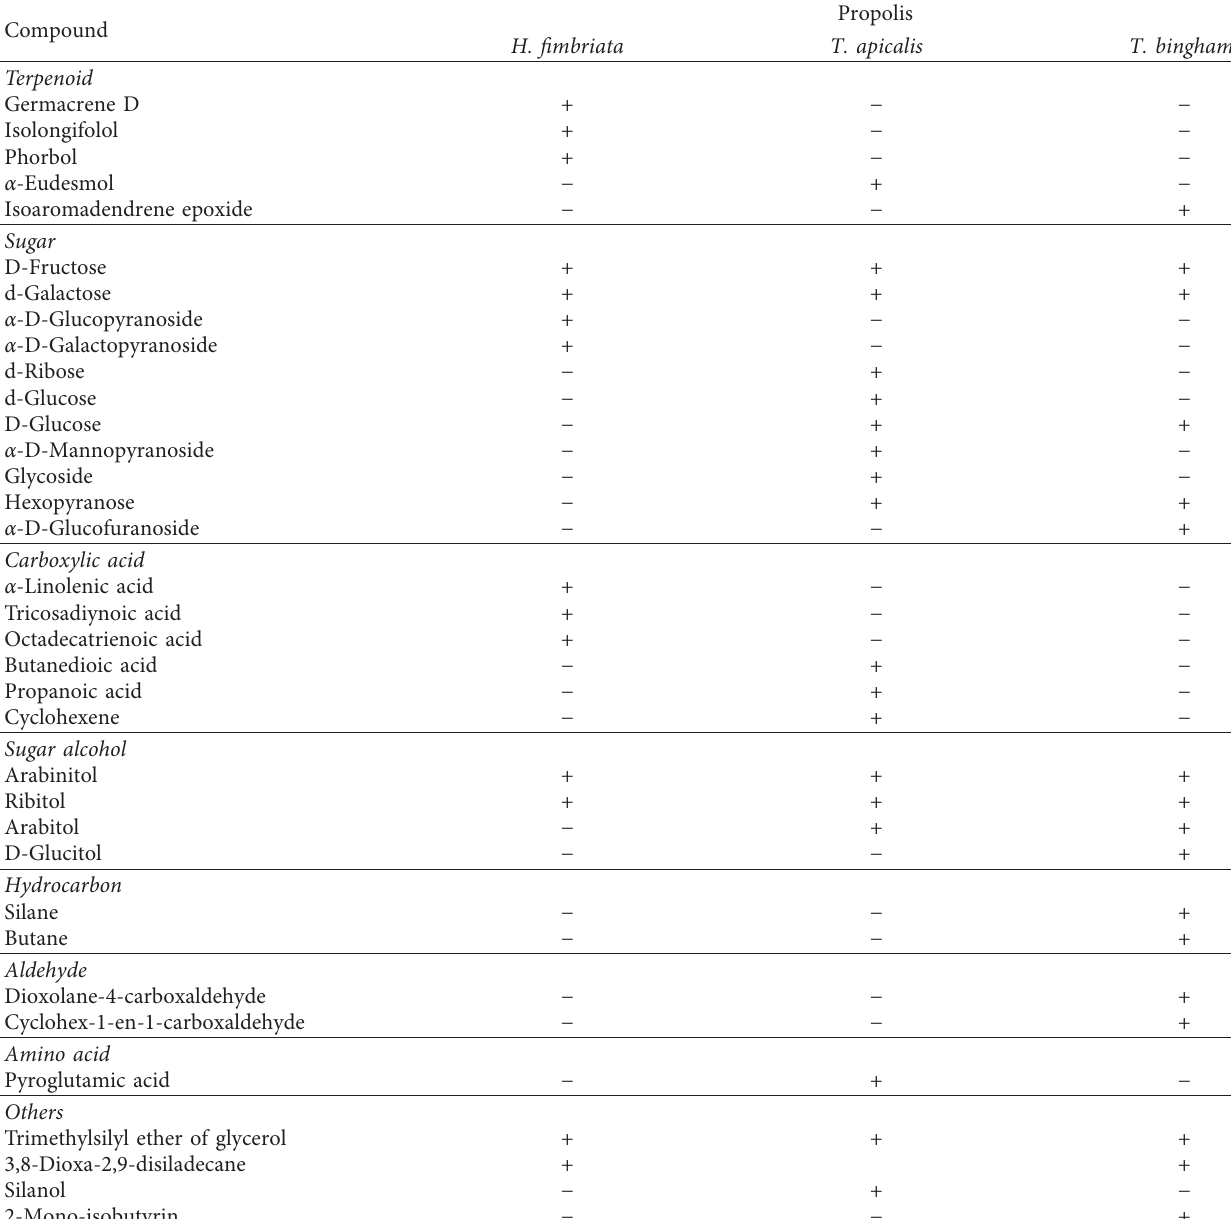
Table 5: Major compounds detected in stingless bee propolis water extracts using GC-MS